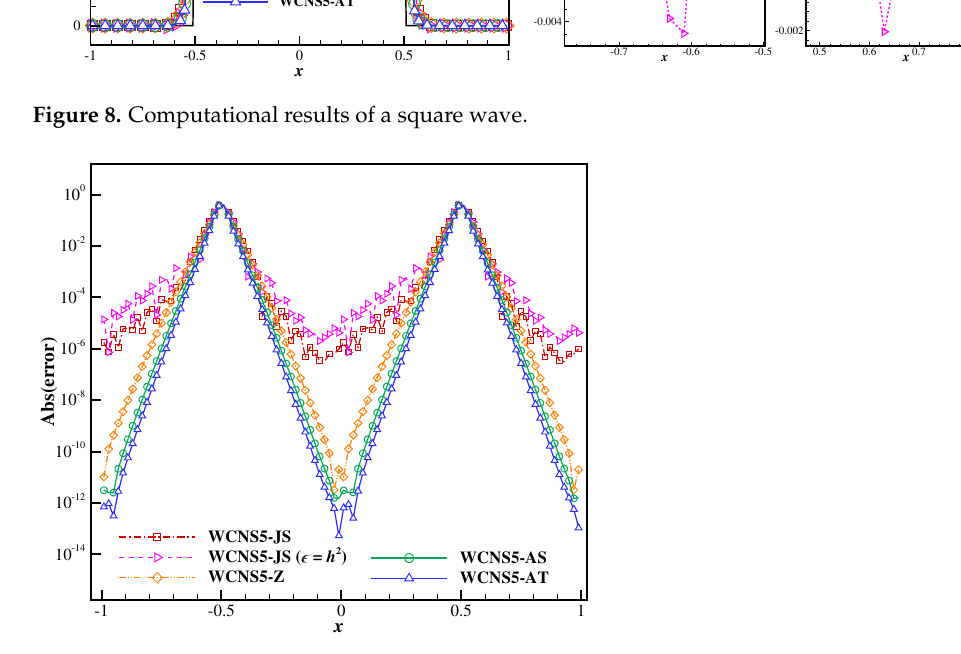
Figure 9. Error distribution of square